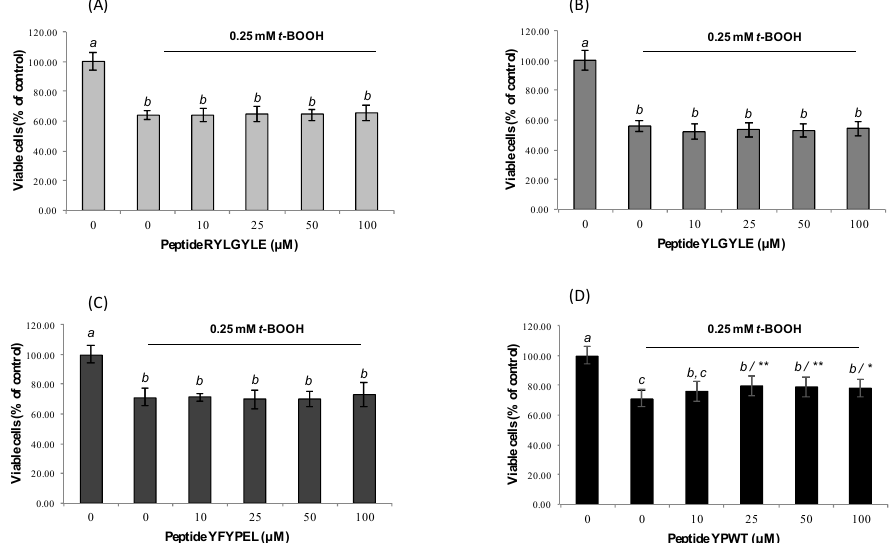
Figure 2. Dose-dependent effects of synthetic animal protein-derived peptides ( A ) RYLGYLE, ( B ) YLGYLE, ( C ) YFYPEL, and ( D ) YPWT on cell viability of stressed macrophages RAW264.7 with 0.25 mM tert-butyl hydroperoxide ( t -BOOH). Cells were pre-treated with peptides at concentrations that ranged from 10 to 100 μ M for 24 h. Results were expressed as the percentage of viable cells compared to control, considered as 100% (% control, mean ± standard deviation (SD), n = 3). Different letters indicate significant differences ( p < 0.05) and ** ( p < 0.01); * ( p < 0.05) significant differences of each concentration versus control under the same experimental conditions (one-way ANOVA followed by Tukey’s multiple comparison test).